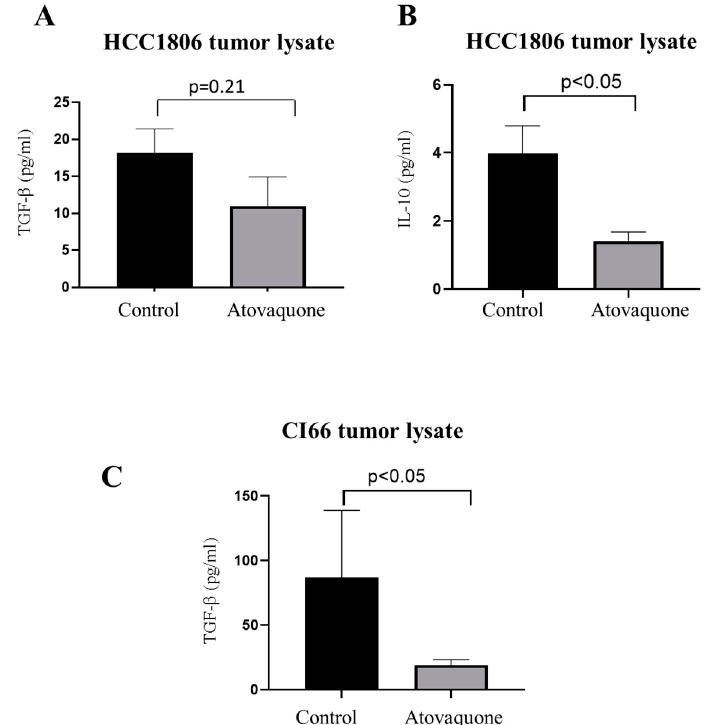
Figure 4. Reduction of immune-suppressive cytokines with atovaquone treatment. Equal amount of protein from HCC1806, as well as CI66 tumors from control and atovaquone-treated mice, was used to perform ELISA assay for TGF- β and IL-10. Bar graph representing ( A ) TGF- β (HCC1806 tumor lysate), ( B ) IL-10 (HCC1806 tumor lysate) and ( C ) TGF- β (CI66 tumor lysate) levels from control and treatment groups. Data shown as mean ± SEM from at least three individual tumor samples. Statistically significant at p < 0.05 when compared with control.